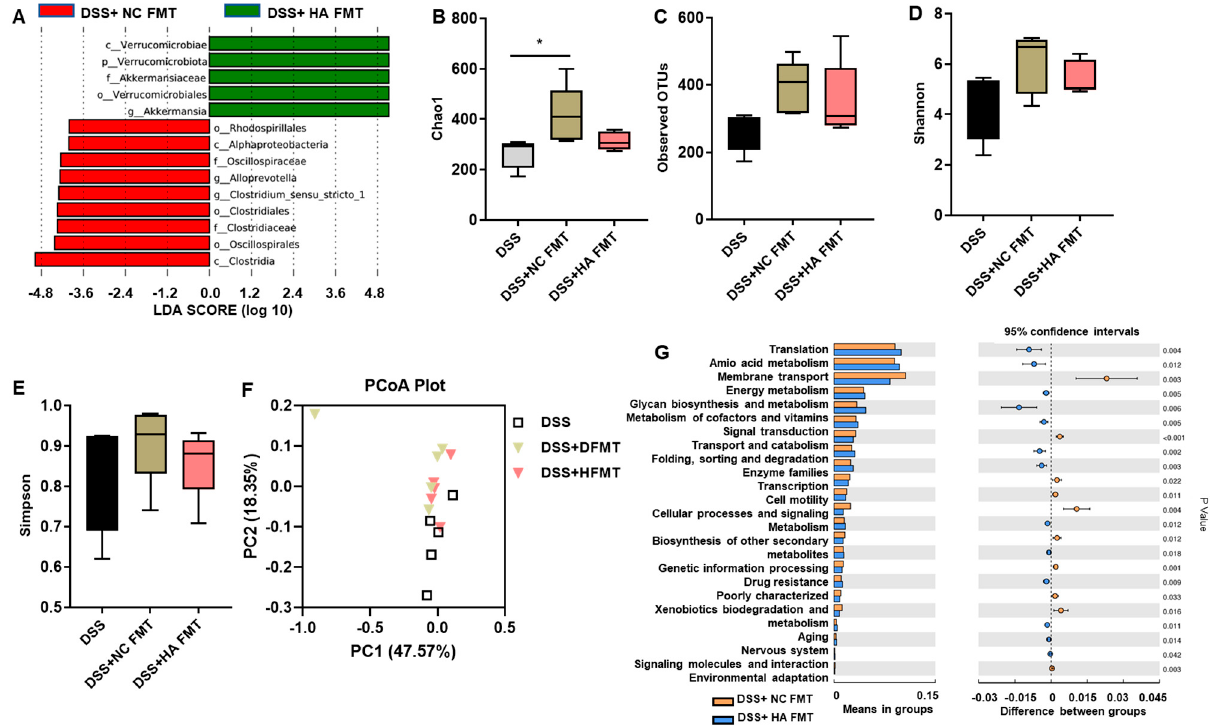
Figure 6. FMT from colitis mice treated with HA increases the abundance of Akkermansia muciniphila . ( A ) The LefSe analysis of the DSS + NC FMT group and DSS + HA FMT group. ( B – E ) The α -diversity analysis of the gut microbiome at the OTU level, determined by the Chao1, Observed OTUs, Shannon and Simpson index. ( F ) The β -diversity analysis by principal component analysis (PCA) plot. (G) The microbial predicted metabolic functional data using Tax4Fun method. Data are expressed as mean ± SE, n = 5, * p < 0.05.